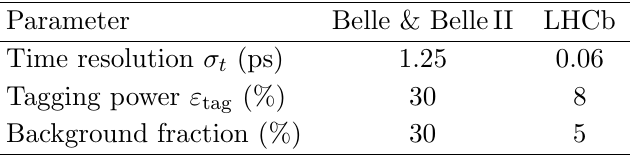
Table 1 . Experimental conditions adopted in numerical experiments.